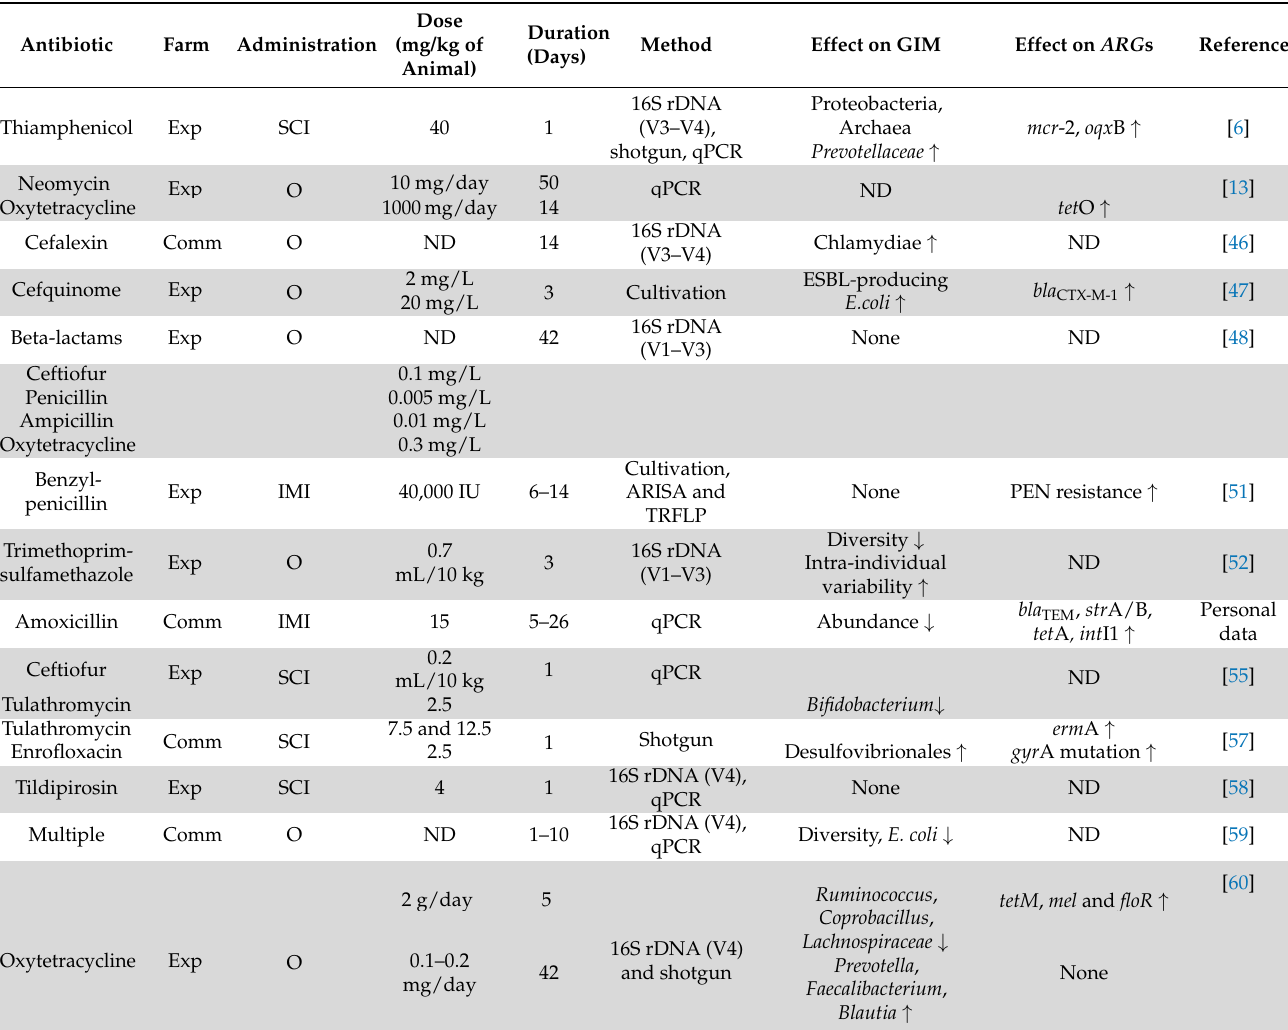
Table 1. Summary of studies investigating impact of antibiotics on bovines’ intestinal microbiota and relative antibiotic resistance